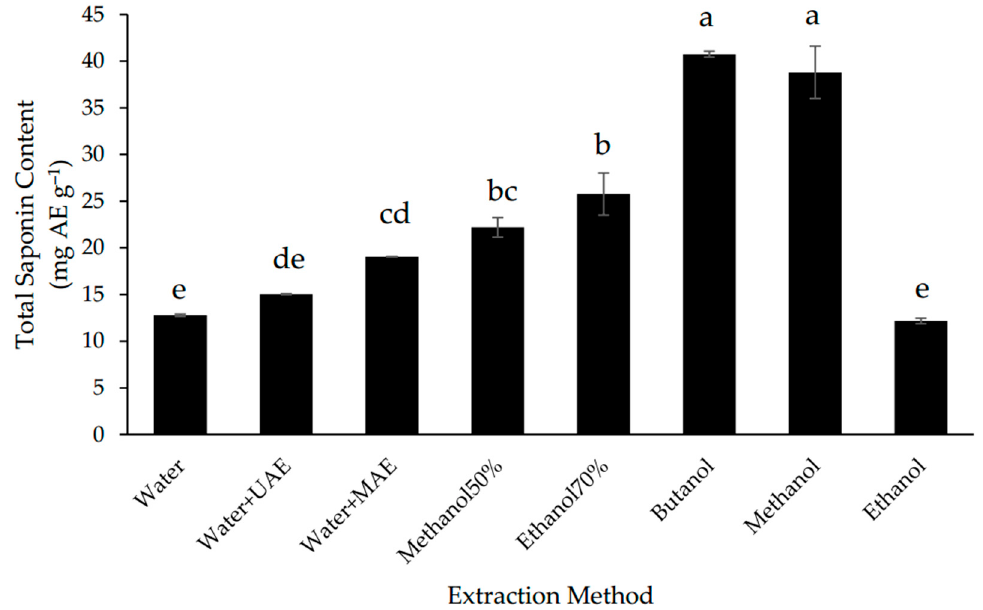
Figure 2. Total saponin content of defatted Gac seed extracts affected by extraction method. The values are the means of three replicates for each extraction. Columns not sharing the same superscript letter are significantly different at p < 0.05. AE: aescin equivalents.